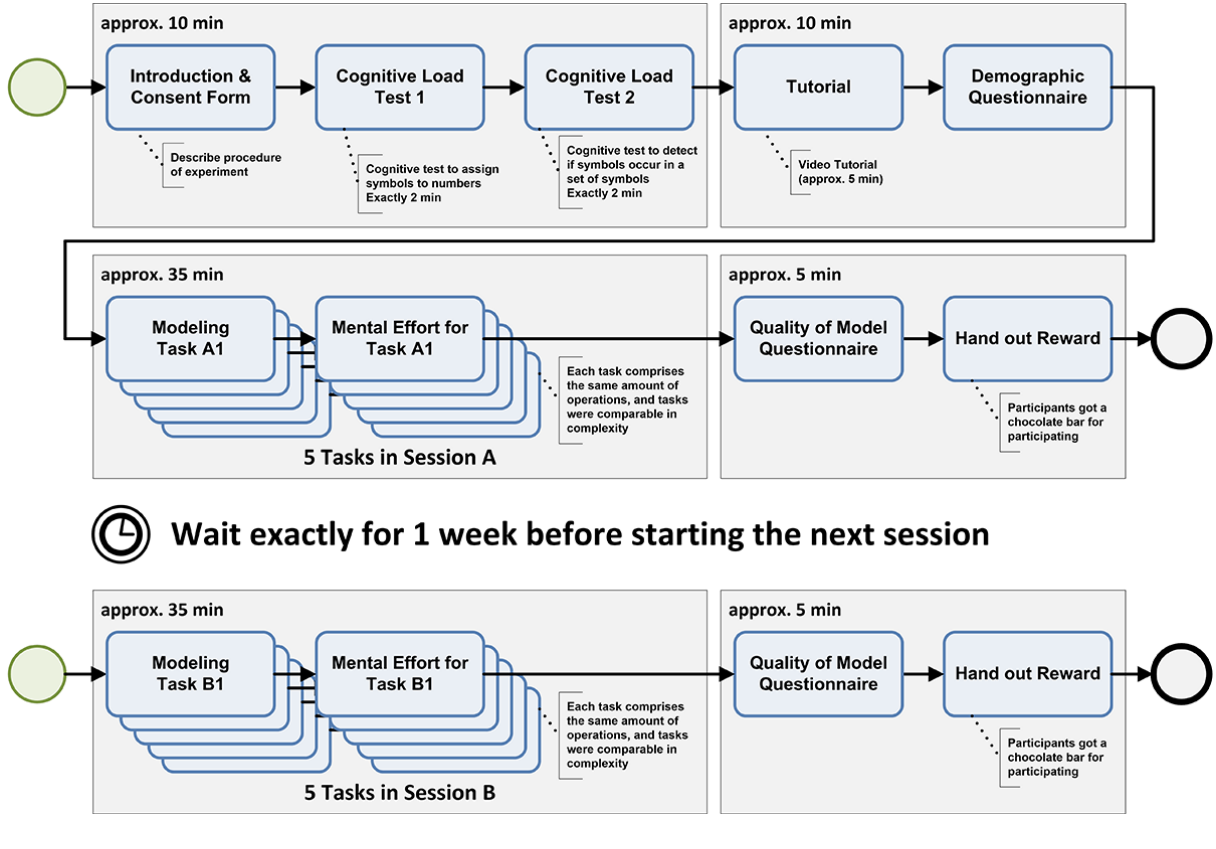
Figure 4. Study design.